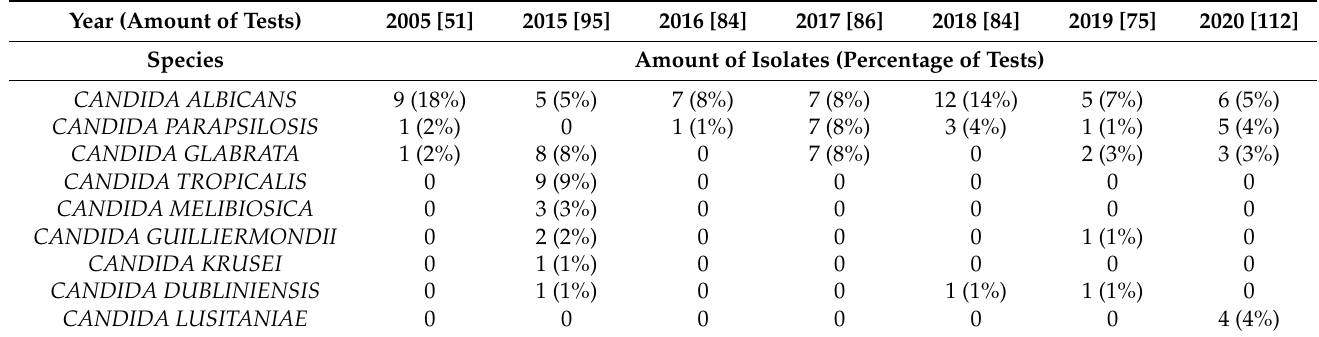
Table 7. Yeast species isolated in PCICU patients from the urinary tract.